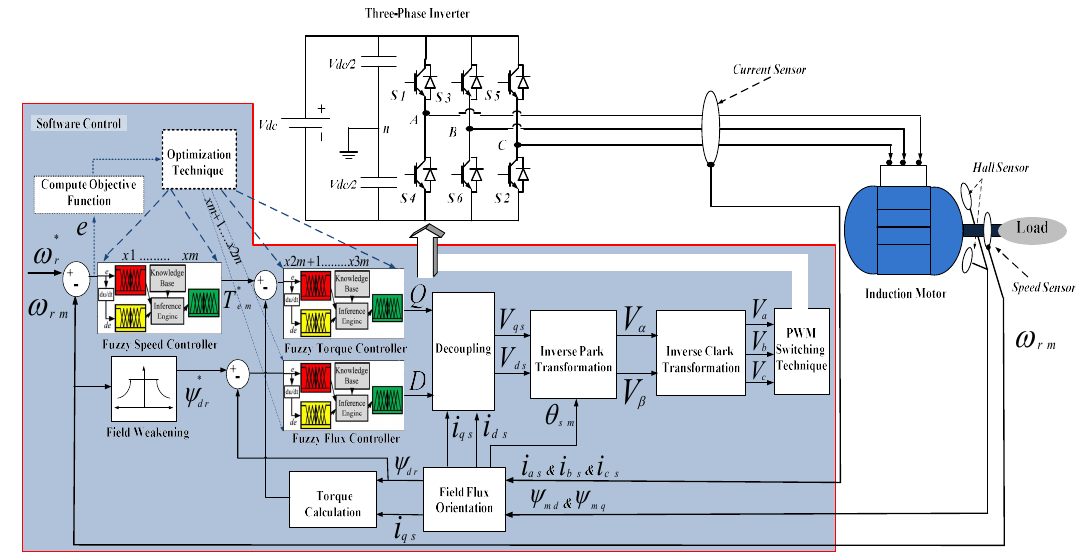
Figure 18. Optimization technique for DFOC based on FLC.